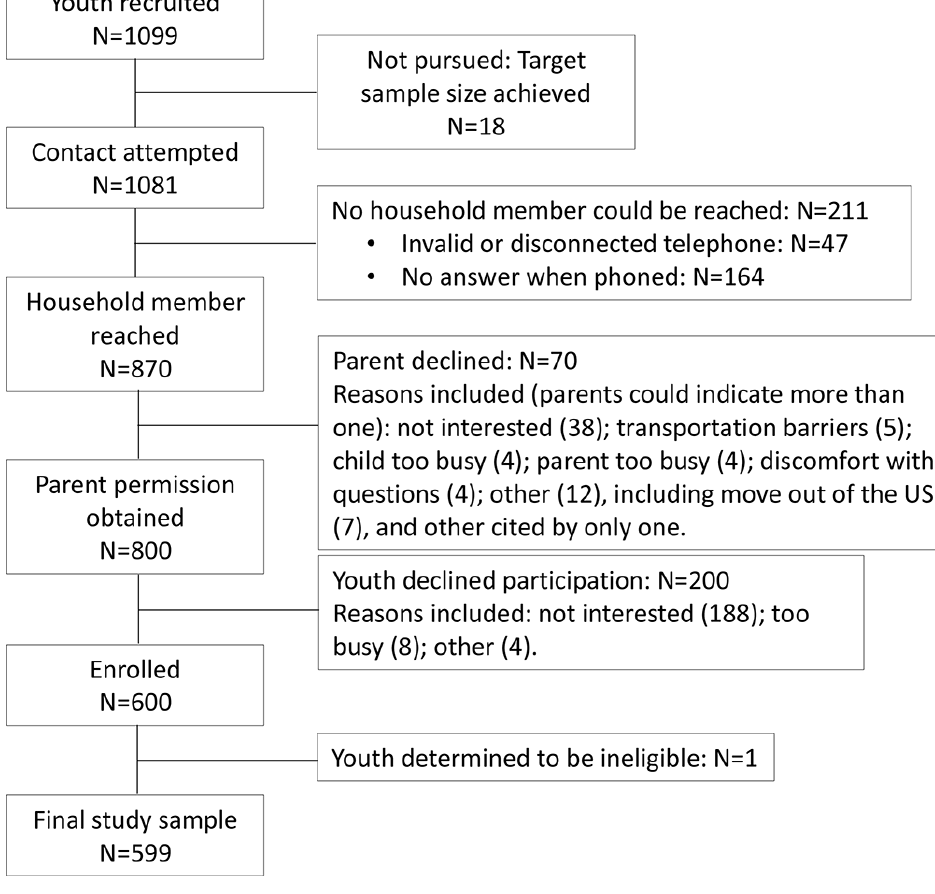
Figure 1 Participant recruitment, household contact, parent permission and